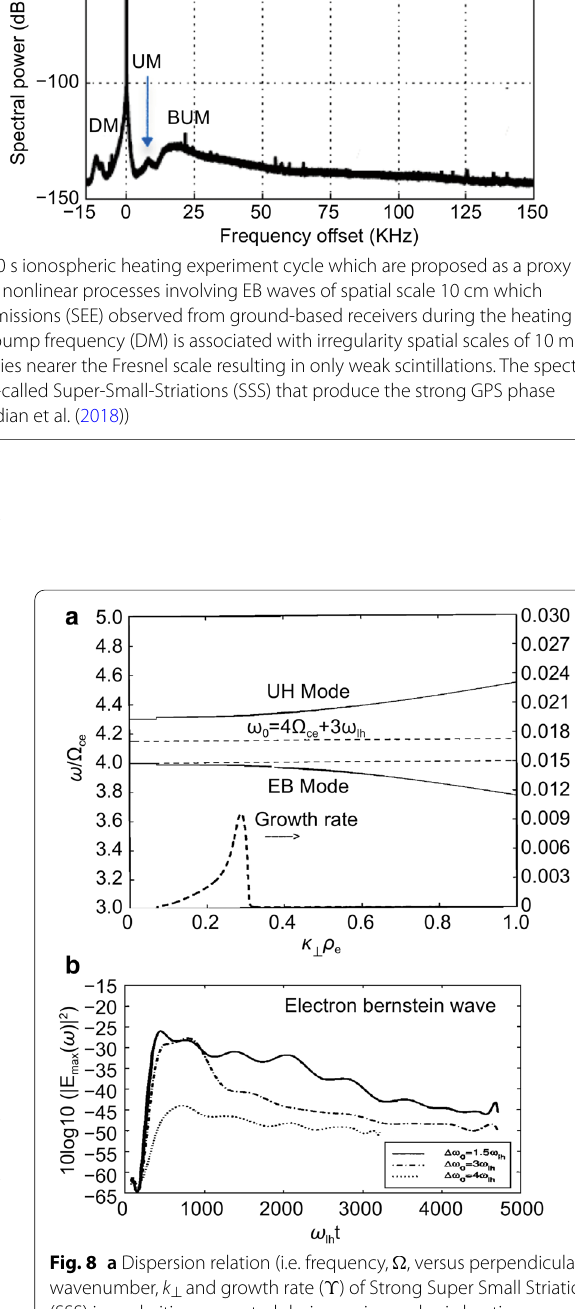
Fig. 8 a Dispersion relation (i.e. frequency, (cid:31) , versus perpendicular wavenumber, k ⊥ and growth rate ( ϒ ) of Strong Super Small Striation (SSS) irregularities generated during an ionospheric heating experiment), proposed to produce GNSS phase scintillations. Note Electron Bernstein (EB) waves are generated in the range k ⊥ ρ e ∼ 0.3, which implies decimeter SSS irregularities. b Nonlinear numerical simulation of SSS showing temporal damping of EB SSS which aligns with the reduction in GPS phase scintillations in Fig. 7 (Mahmoudian et al. 2018) (Adapted from Xi and Scales